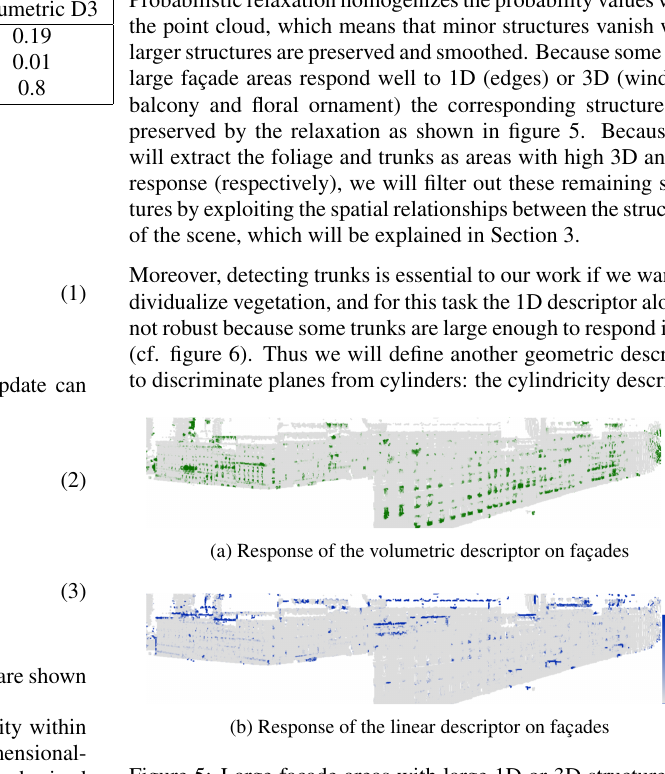
Figure 5: Large façade areas with large 1D or 3D structures not removed by the